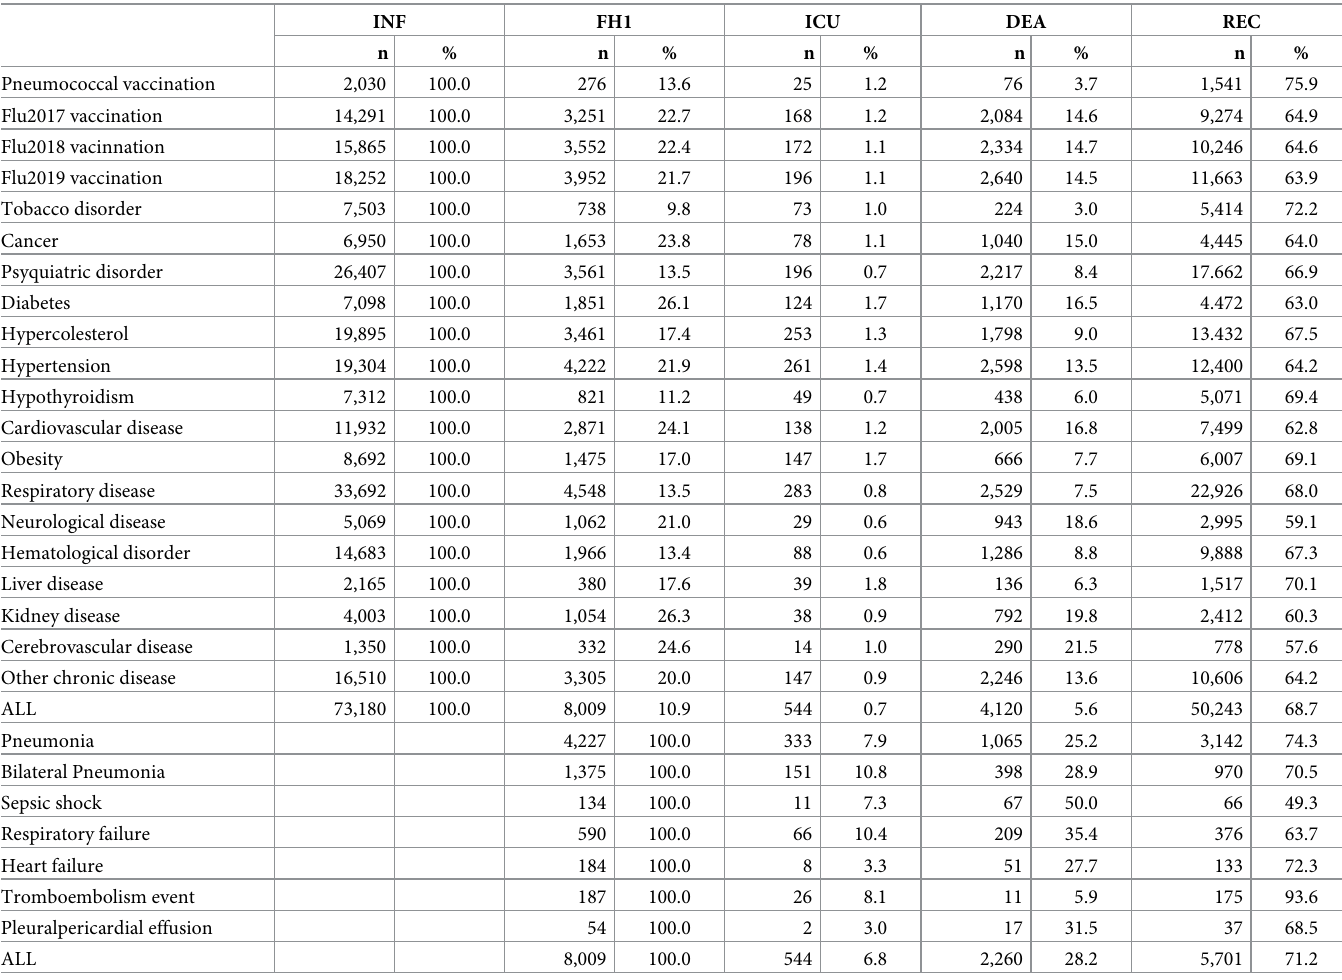
Table 2. Distribution of patients by comorbidities, complications and